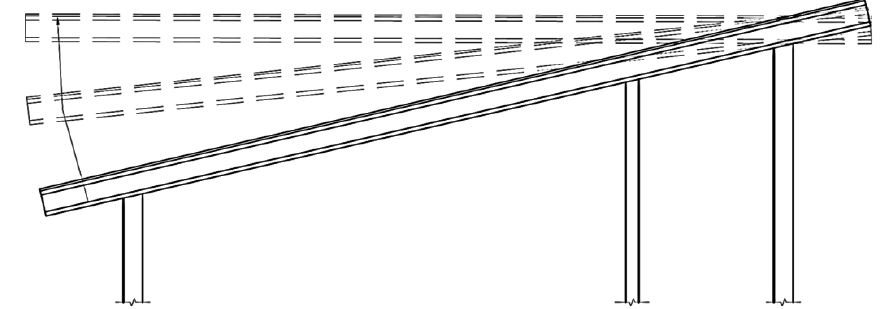
Figure 11. Roof failure